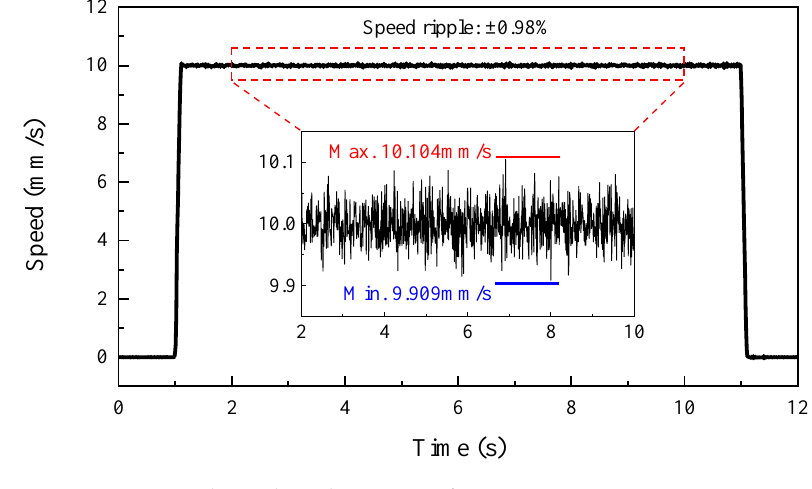
3.0 m/s and acceleration = 40 m/s 2 ).